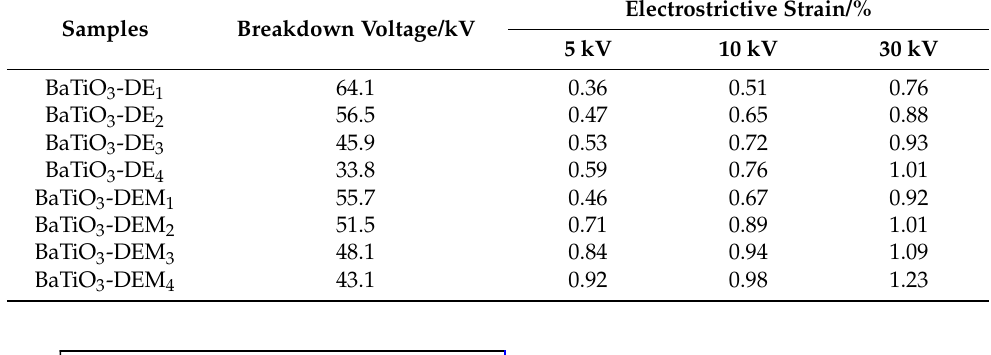
Figure 5. Comparison diagram of breakdown voltage between two kinds of samples.